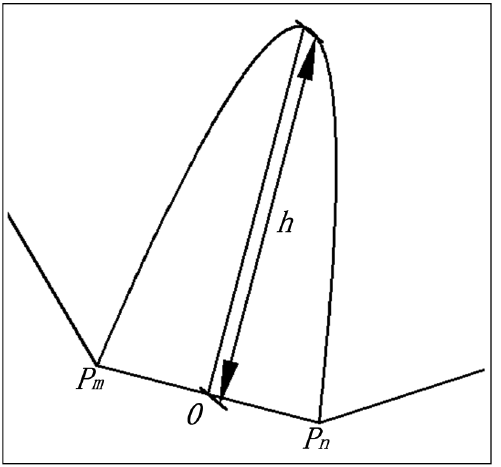
Figure 2. Parabola-limited retracted structure where the retracted boundary P m P n is one of the convex hull borderlines, and h is the retracting depth.